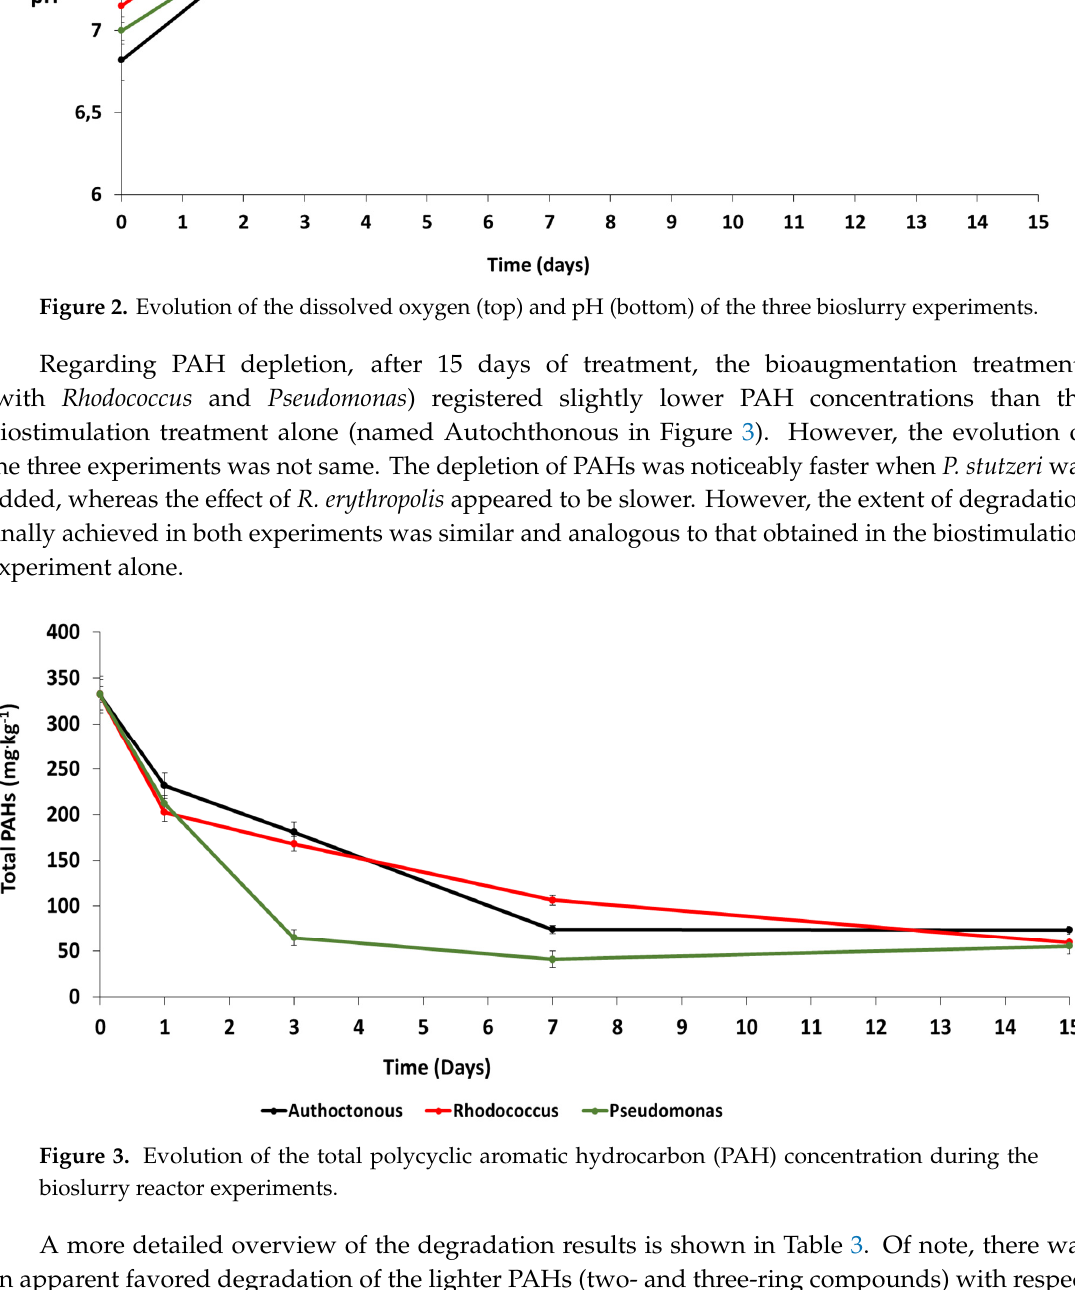
Figure 3. Evolution of the total polycyclic aromatic hydrocarbon (PAH) concentration during the bioslurry reactor experiments.